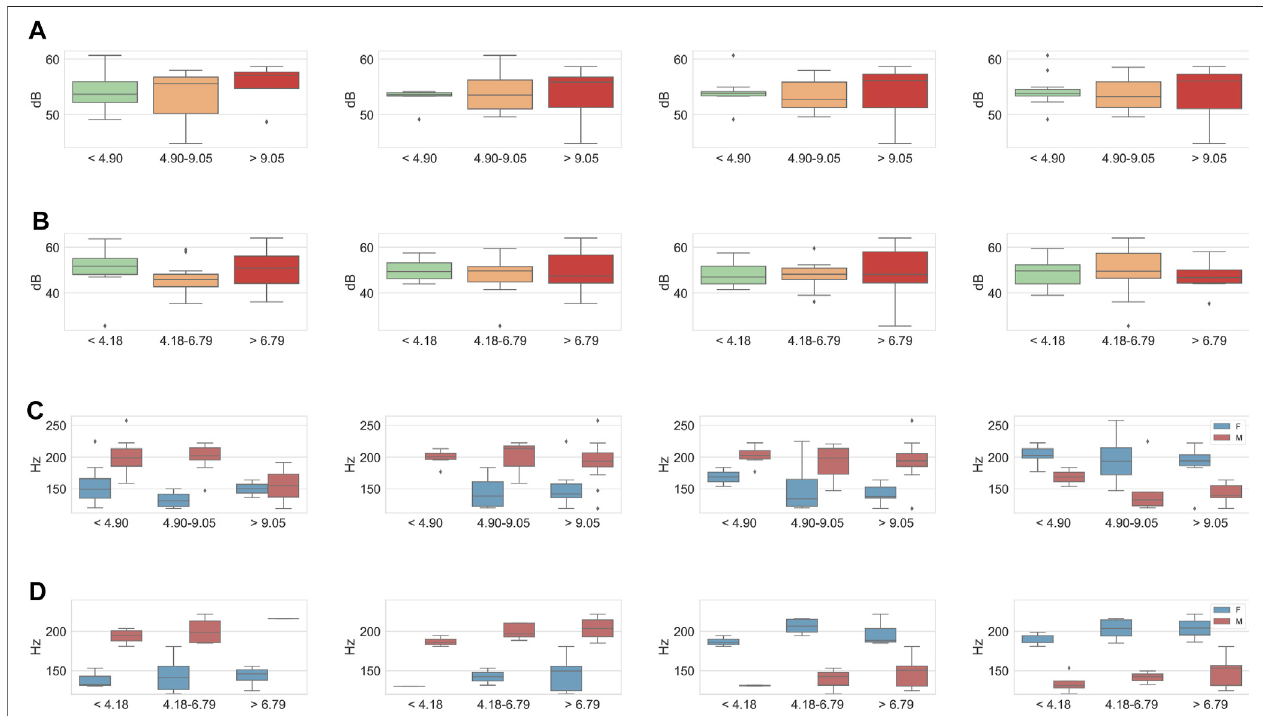
FIGURE 3 | Box plot representation of extracted intensity (dB) and pitch ( F 0 ) for each speaker. Percentile grouping based on raw cortisol as nmol/L, showing measures taken at time-points S1, S3 – S5, for FAU-TSST and REG-TSST corpora. (A) Intensity dB — FAU-TSST S1,S3 — S5. (B) Intensity dB — R EG -TSST S1, S3, S3 — S5.